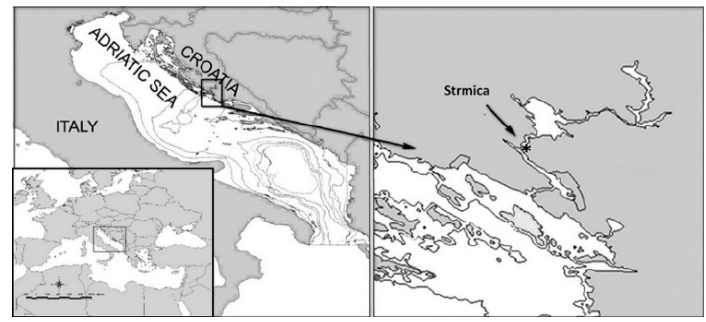
Figure 1. Study area showing a sampling station Strmica in the Krka River estuary.